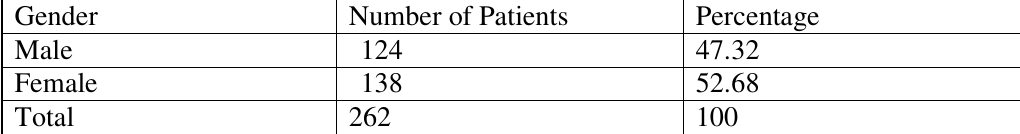
Table-2: Distribution of Patient according to sex